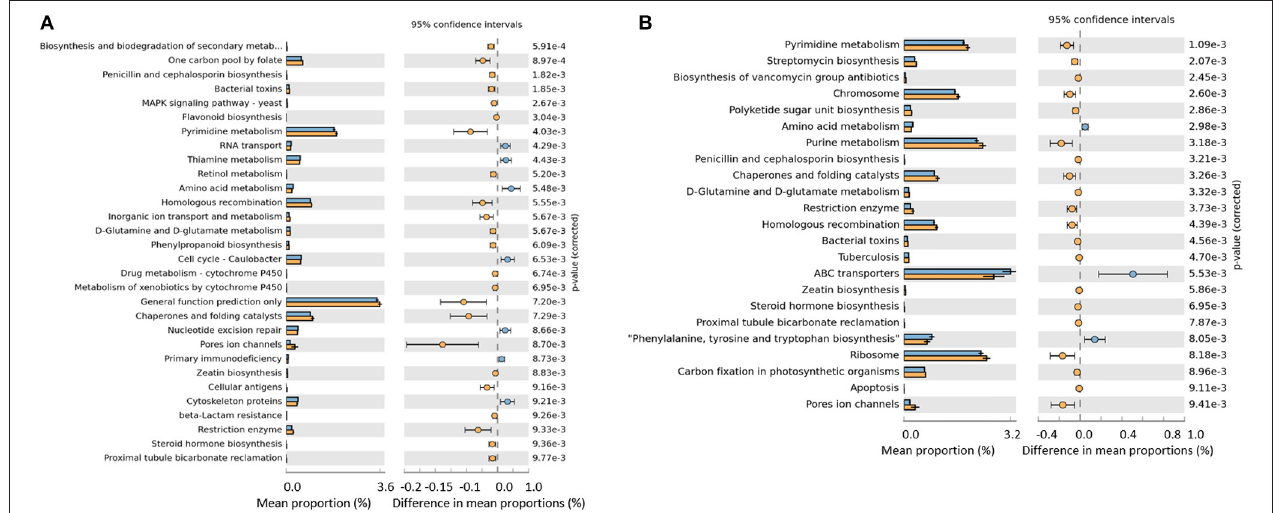
FIGURE 5 | Predicted functions of the cecal microbiota unique to challenged and sodium butyrate supplemented birds (A) and unique to challenged and sodium butyrate plus essential oils supplemented birds (B) comparing 12 d (blue bars) vs. 21 d (orange bars) with P ≤